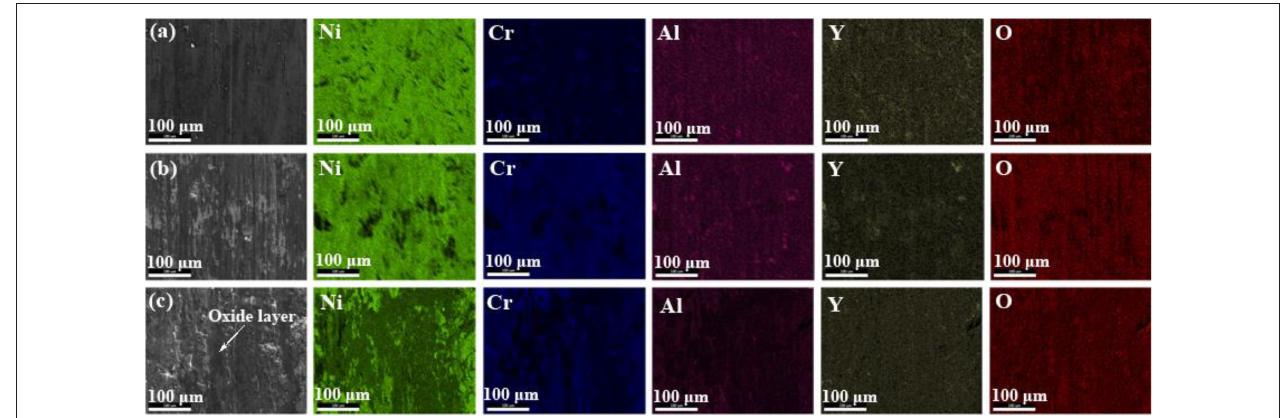
FIGURE 13 | Curves of coating heat treatment at 1,100 ◦ C oxidized for 100h at different test temperatures.